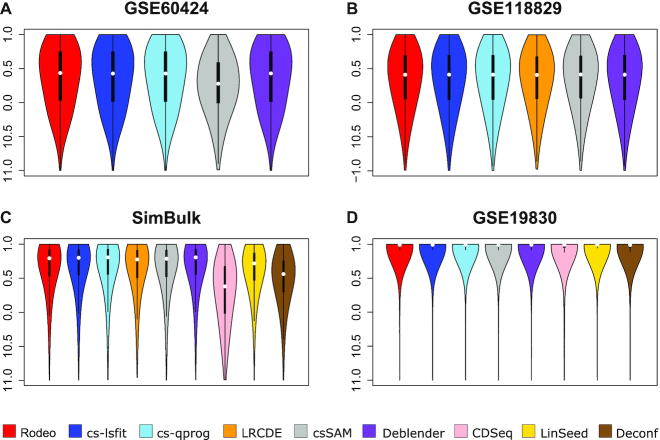
Correlations between known and estimated gene profiles in datasets (A) GSE60424, (B) GSE118829, (C) SimBulk and (D) GSE19830. Violin plots for tested methods (x-axis) show the distribution of genes’ correlations (y-axis).